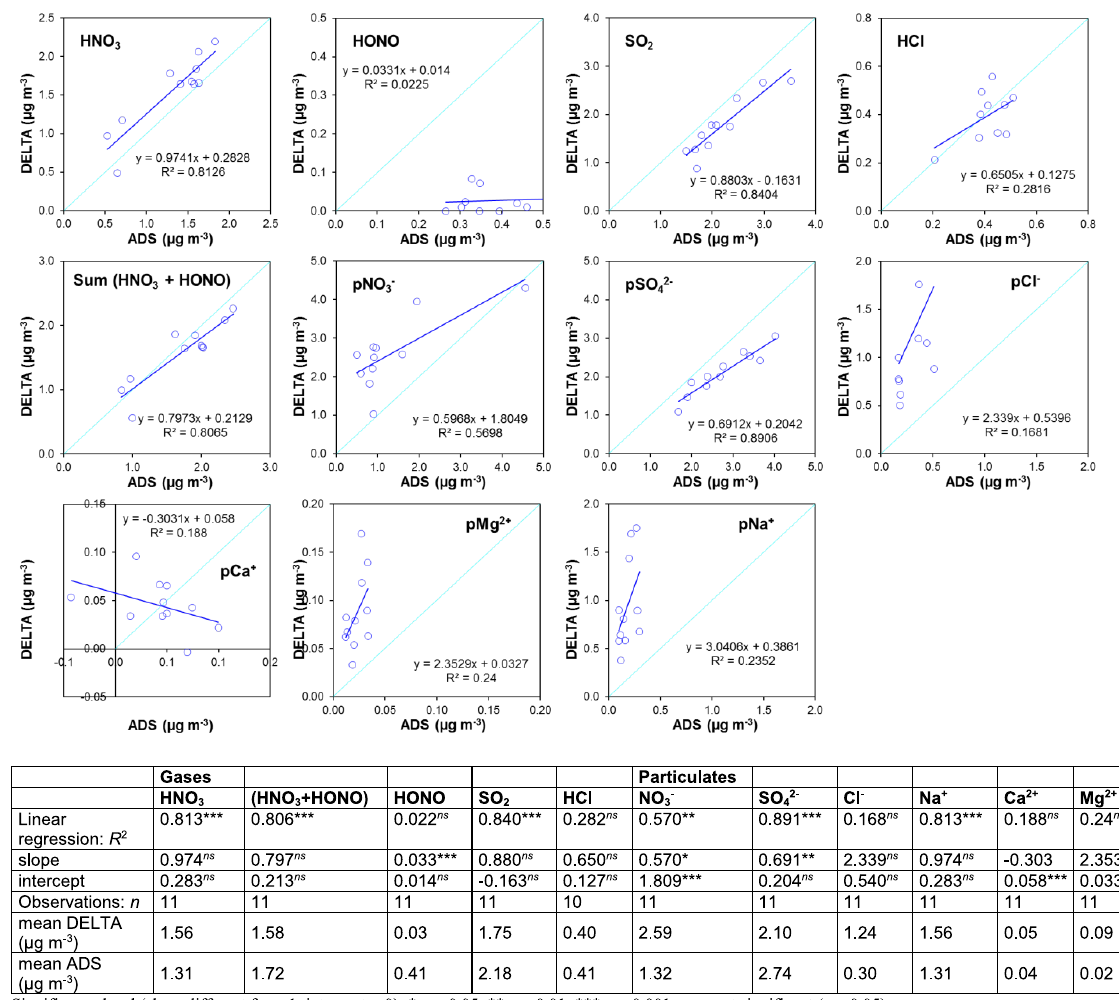
Figure 3. Comparison of HNO 3 , HONO, sum (HNO 3 + HONO), SO 2 , HCl and aerosol NO − by the Acid Gases and Aerosol Network (AGANet) DELTA method with available measurements from the collocated ChemSpec Daily Annular Denuder system (ADS) at Barcombe Mills (UKA00069). Mean concentrations were derived from the average of daily ADS data for the corresponding DELTA sampling periods (monthly). HNO 3 values shown for DELTA and ADS are as calculated from the amount of NO − collected on the denuders and have not been adjusted by a bias correction factor (see Sect. 2.6). A summary of the regression analyses 3 is provided in the table below the